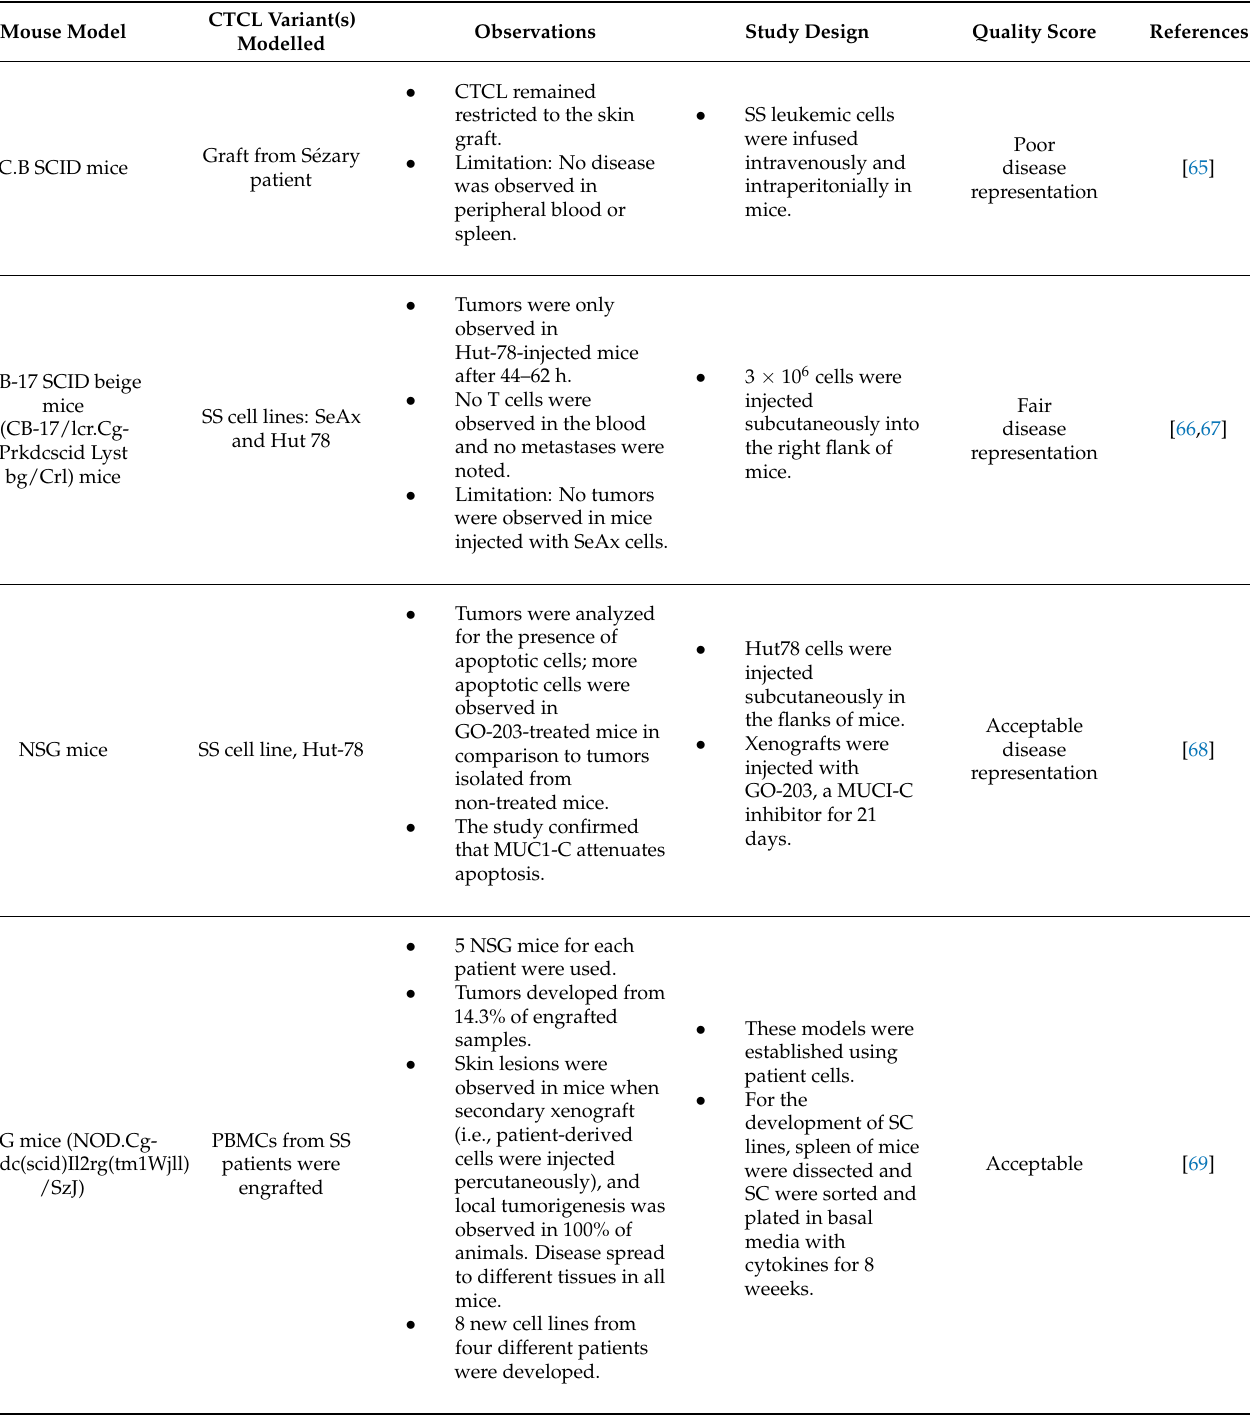
Table 2. Detailed description of xenograft/GEMM mouse models used to study